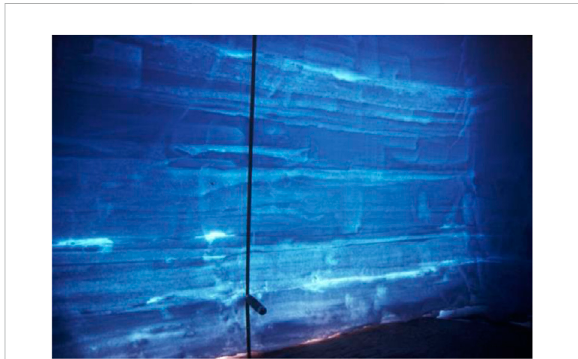
FIGURE 3 Stratigraphy revealed in a back lit 2 m deep snow pit wall located excavated in west central Greenland. The layering is primarily a result of annual snow deposition and densi fi cation. Bright objects are ice lens formed by the downward trickle of summer melt until interrupted by less permeable layers (Photo courtesy of M. Anderson).